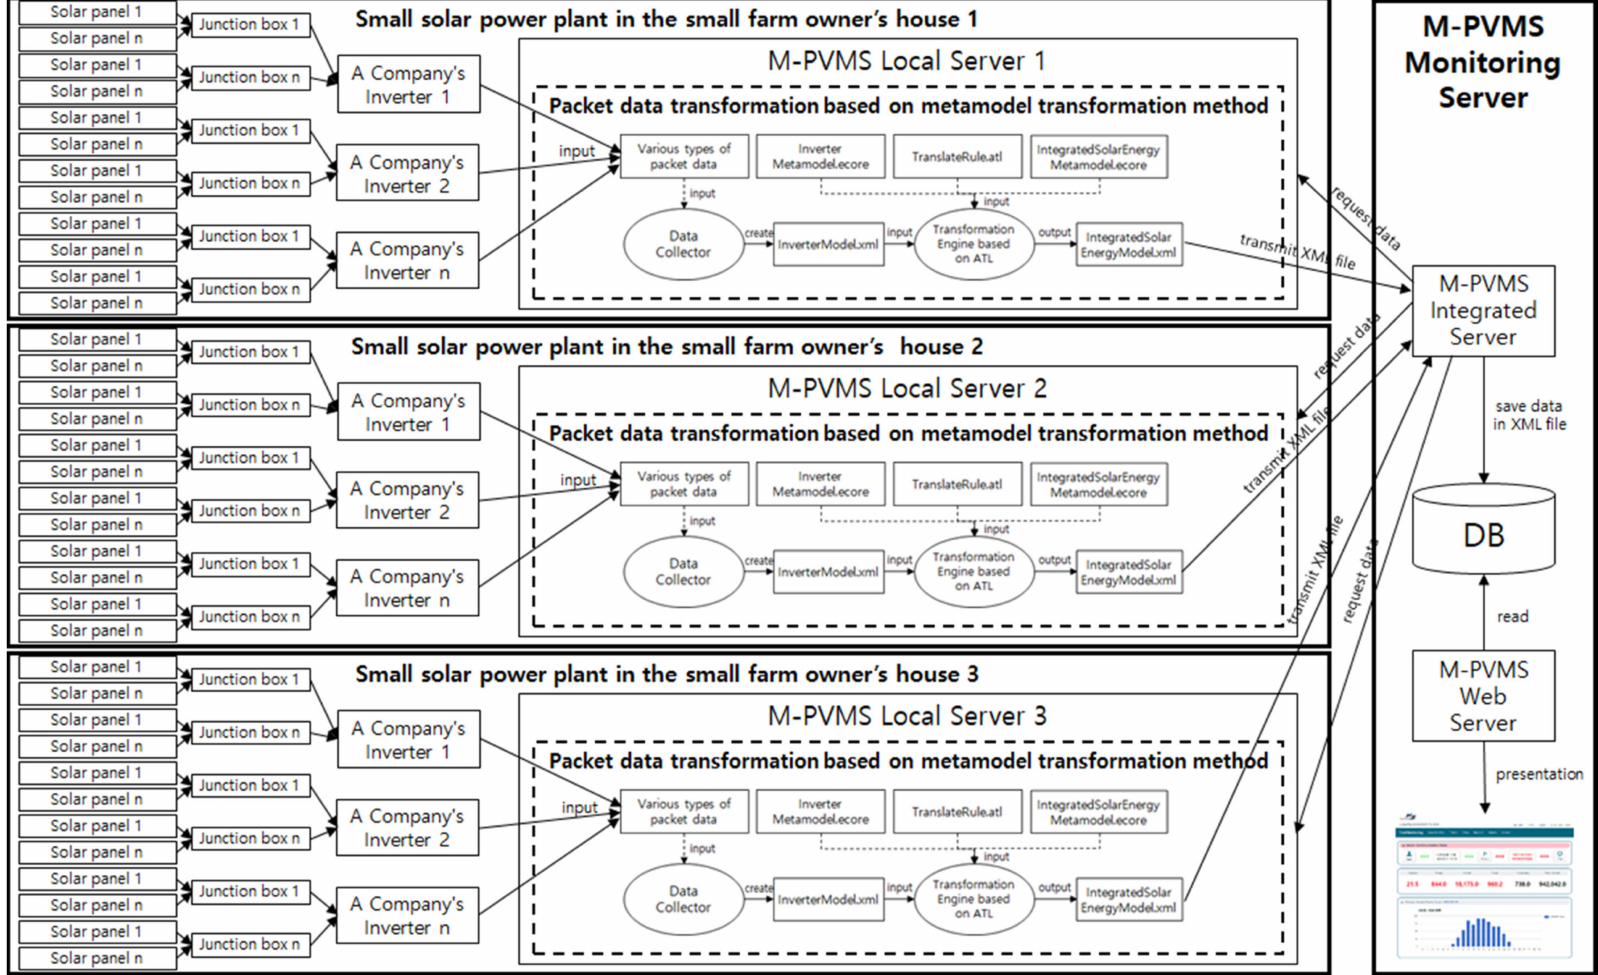
Figure 3. Structural diagram of proposed metamodel-based photovoltaic monitoring system